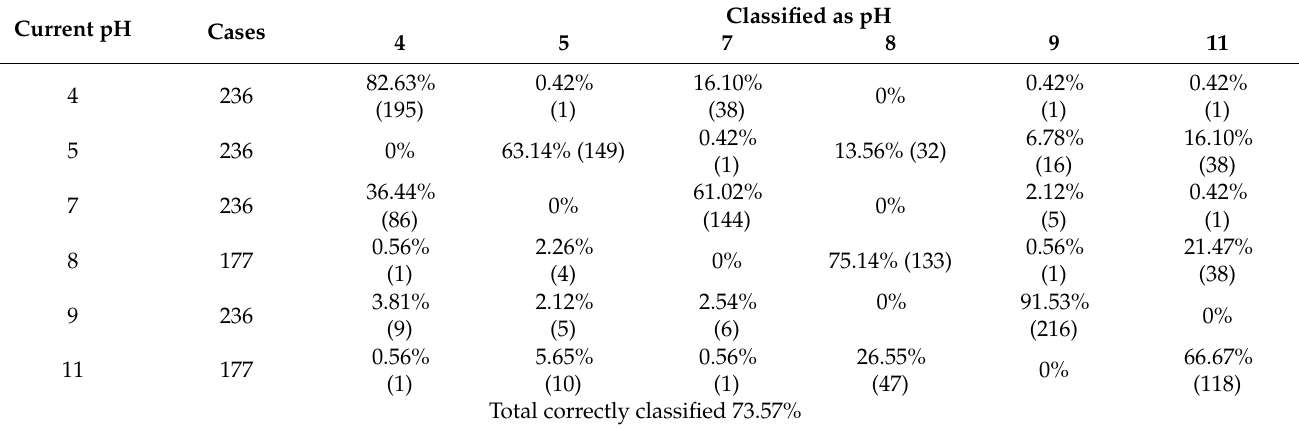
Table 11. Classification results of PNN using all cases and frequency, Vpp, and delay as input